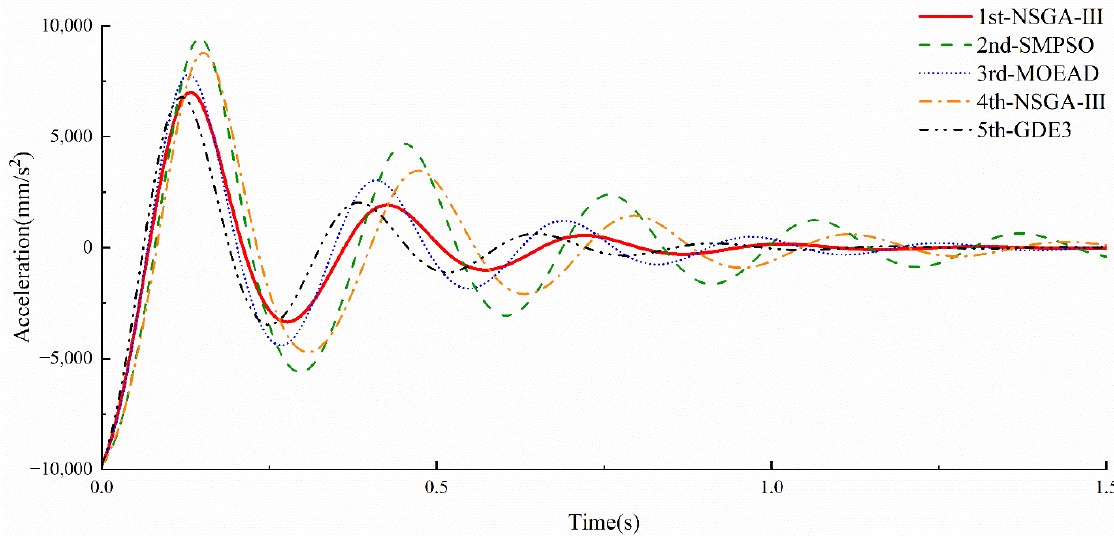
Table 8. Parameters of the globally optimal solution (obtained by NSGA-III) in the partial differen- tial equation model compared with those in the Adams model.